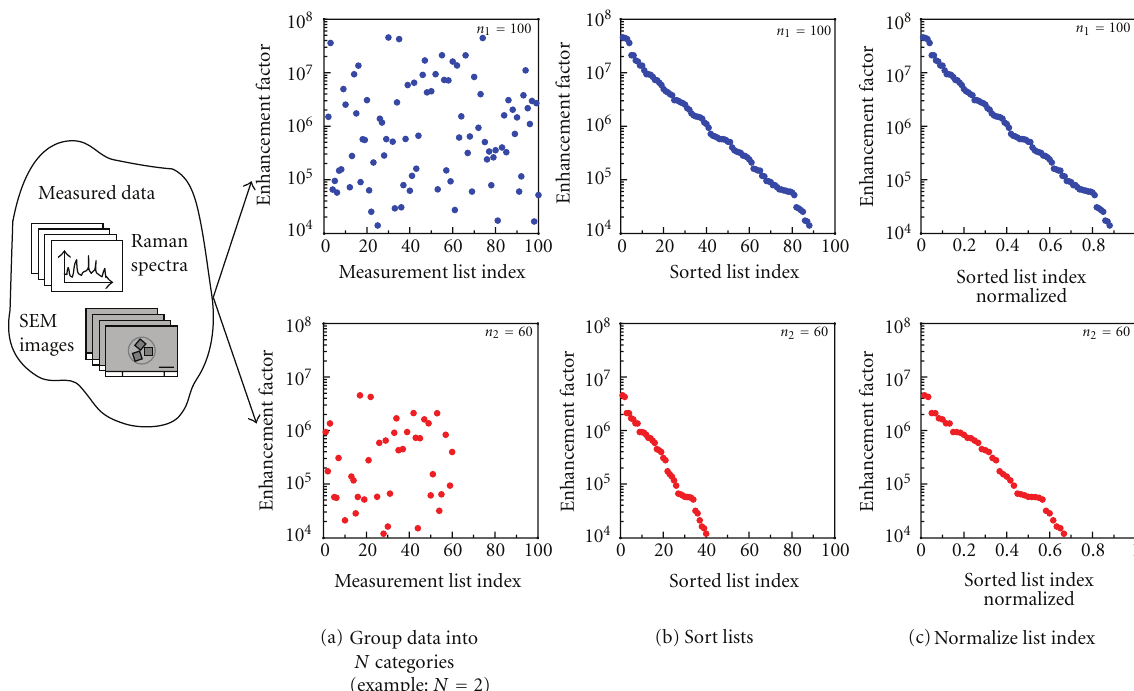
Figure 3: Analysis of SSEF data. (a) The data is grouped into N categories ( N = 2): set 1 consists of a list of n 1 = 100 values (blue), and set 2 consists of a list of n 2 = 60 values (red). The list content is plotted against the list index that indicates the sequence in which the data was collected and has no physical meaning. (b) The values within each category are sorted in descending order. (c) The list index is normalized to allow a direct comparison between the lists. The normalized list indices are 0 . 01,0 . 02, ... ,1 for set 1 with n 1 = 100 (blue) and 1 / 60,1 / 30,1 / 20, ... ,1 for set 2 with n 2 = 60 (red). Note that 12% of the SSEF values in set 1 and 33% of the values in set 2 are lower than 10 4 and thus are not displayed in any of the